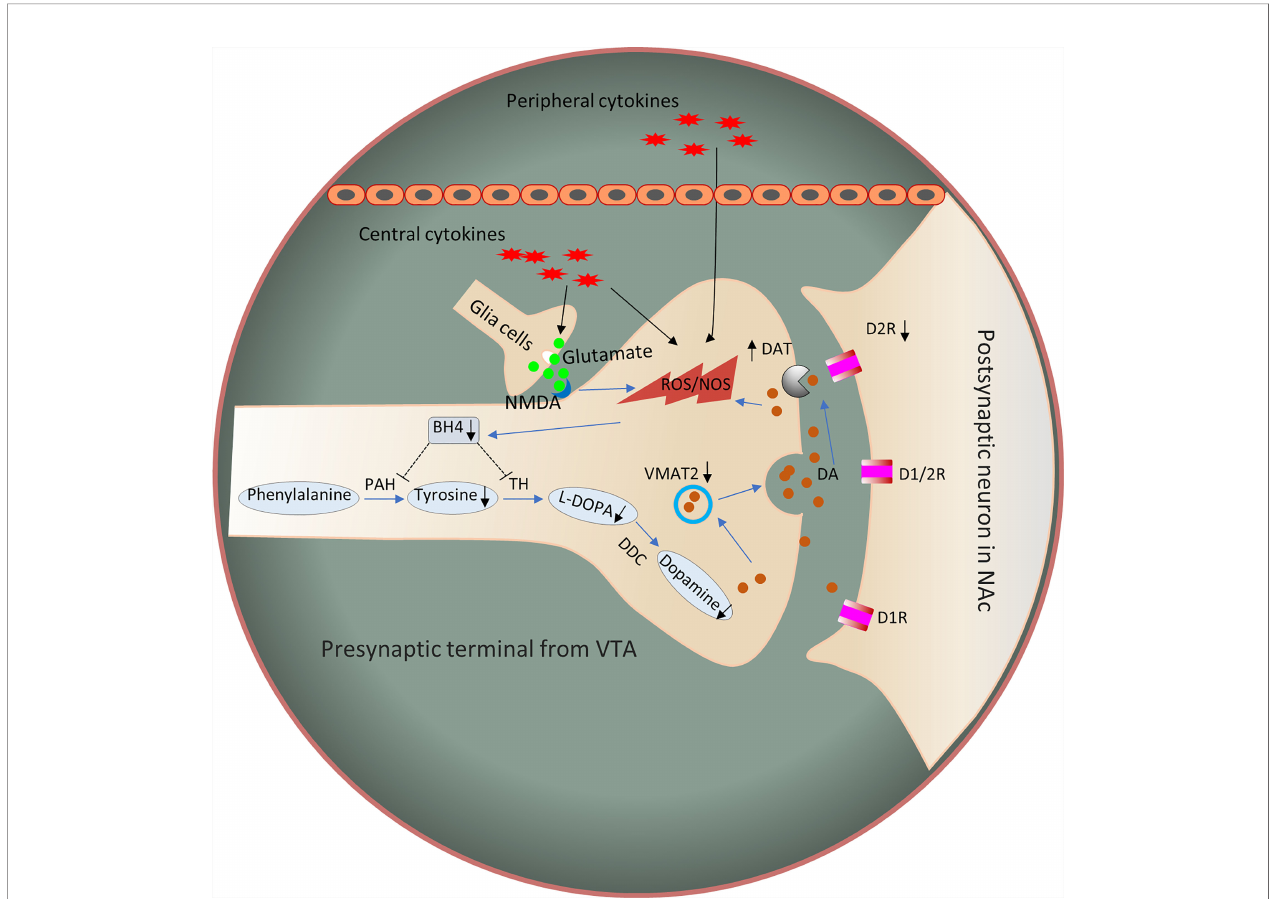
FIGURE 2 | Potential mechanisms by which in fl ammation affects DA signaling through synthesis, release, and receptor function. In fl ammation and cytokines released from the periphery or produced locally by activated microglia or in fi ltrating macrophages contribute to oxidative stress and the production of reactive oxygen species (ROS). Increased ROS and in fl ammation-induced nitric oxide levels contribute to the oxidation of BH4, an essential cofactor required for the conversion of phenylalanine to tyrosine and tyrosine to L-PODA, which are necessary for the synthesis of DA. In addition, the increased glutamate release and reduced reuptake by in fl ammation-induced glial cells, coupled with the activation of NMDARs, may cause excitotoxicity of glutamate. In turn, these changes lead to oxidative stress and decreased DA availability. Furthermore, some evidence has shown that in fl ammatory cytokines reduce the expression or function of VMAT2 and/or increase the expression or function of DAT and reduce DA signaling by reducing the levels of DA D2 receptors. Dysregulation of DAT and VMAT2 increases cytosolic DA levels, leading to auto-oxidation and ROS generation. D1R, dopamine 1 receptor; D2R, dopamine 2 receptor; DDC, dopamine decarboxylase; NMDAR, N-methyl-D- aspartic acid receptor; NOS, nitric oxide synthase; ROS, reactive oxygen species; PAH, phenylalanine hydroxylase; TH, tyrosine hydroxylase; BH4, 5,6,7,8- tetrahydrobiopterin; VMAT2, vesicular monoamine transporter 2; LPODC,